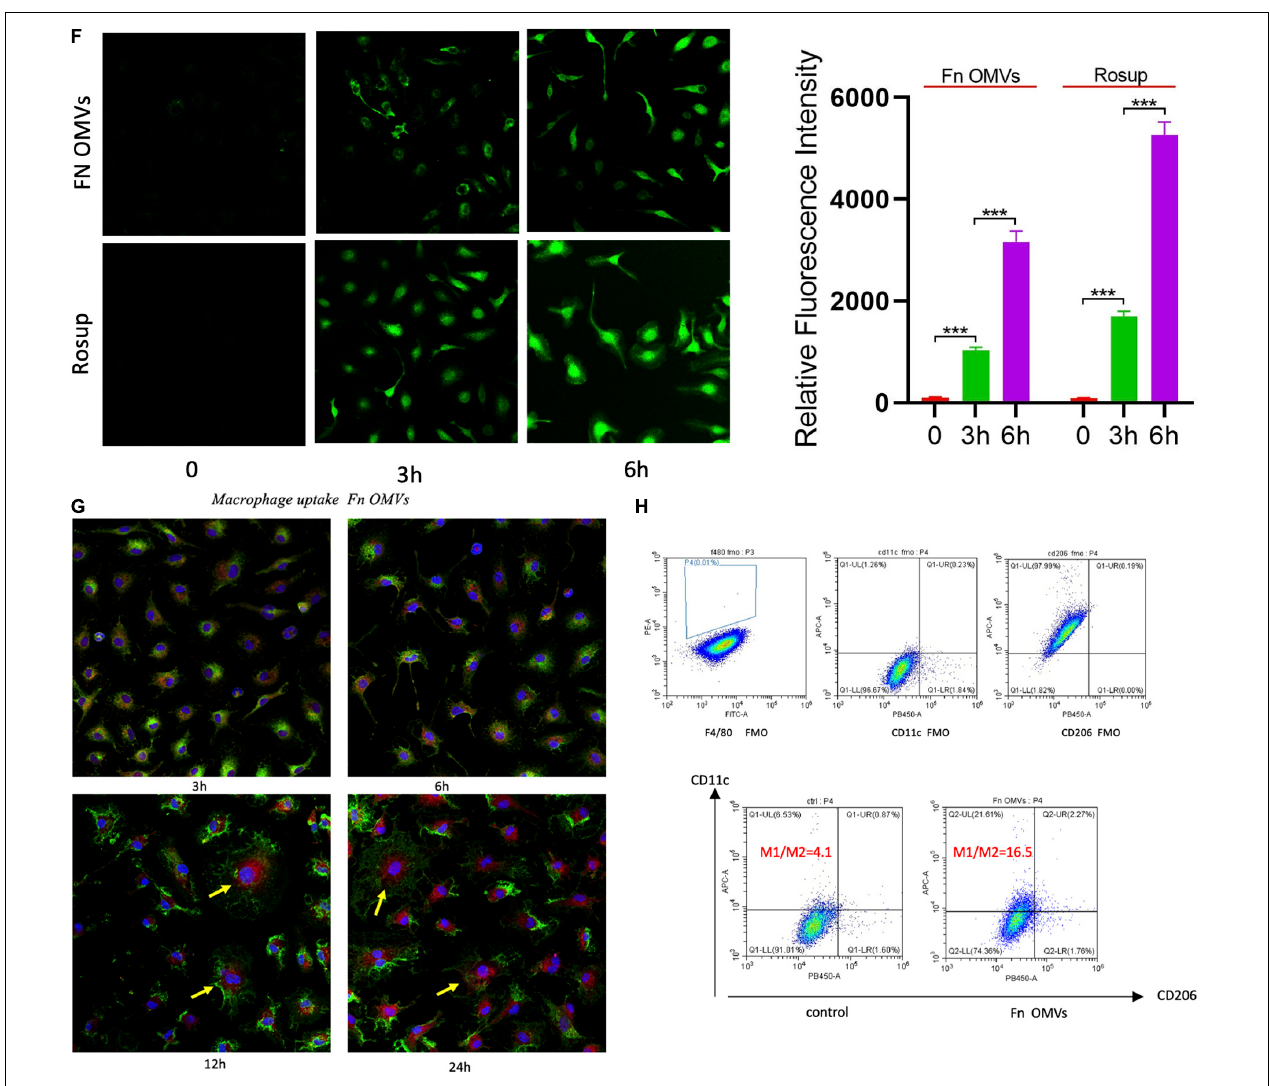
FIGURE 2 | Fusobacterium nucleatum OMVs induce significant proinflammatory profiles and oxidative stress in macrophages. (A) BMDMs were stimulated separately with F. nucleatum OMVs (1.0 µ g/ml), M1 macrophages (100 ng/ml) together with IFN- γ (50 ng/ml) or M2 macrophages (10 ng/ml) together with IL-13 (10 ng/ml) for 24 h. BMDMs were stimulated with F. nucleatum OMVs for 24 h and were morphologically similar to M1 macrophages. (B) F. nucleatum OMVs upregulated the expression of the cytokines TNF- α and iNOS, M1 macrophage markers. The expression of P-p65 was increased in macrophages, indicating that the OMVs activated the NF- κ B pathway. (C) The mRNA level of TNF- α and iNOS increased significantly after OMVs stimulation for 24 h. (D) The fluorescence intensity of the M1 biomarkers iNOS were brightest in BMDMs stimulated with F. nucleatum OMVs (10 µ g/ml) for 12 h. (E) Flow cytometry results showed that the expression of CD11c was most expression at F. nucleatum OMVs stimulation for 12 h. Furthermore, after more OMVs stimulated BMDM, CD11c expression increased. (F) The ROS levels were increased in macrophages stimulated with F. nucleatum OMVs for 3 h. ROS staining was brighter at 6 h than at 3 h. (G) Macrophages exhibited an morphology after being stimulated for 12 h. F. nucleatum OMVs were phagocytosed into cells and appears to surround cell nucleus. (yellow: cell nuclei; red: OMVs; green: membrane). (H) After the stimulation of RAW264.7 cells with F. nucleatum OMVs for 24 h, flow cytometry analysis revealed that the M1/M2 cell ratio was increased by fourfold compared with that in the control group. * P < 0.05, ** P < 0.01, *** P < 0.001. FMO controls are as followed: F4/80 FMO control cells stained with FITC, BV 421, and APC conjugated antibodies. CD206 FMO control cells stained with FITC, PE, and APC conjugated antibodies. CD11c FMO control cells stained with FITC, PE, and BV 421 conjugated